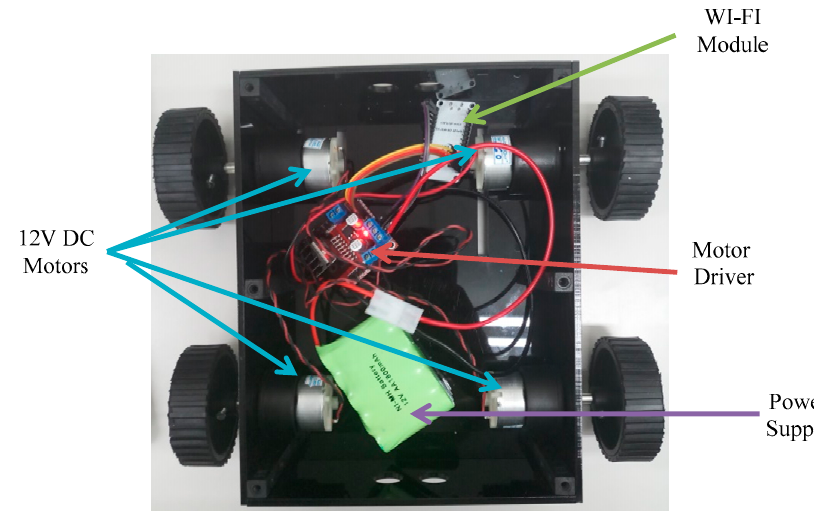
Figure 6. Configuration of the four-wheeled mobile platform.